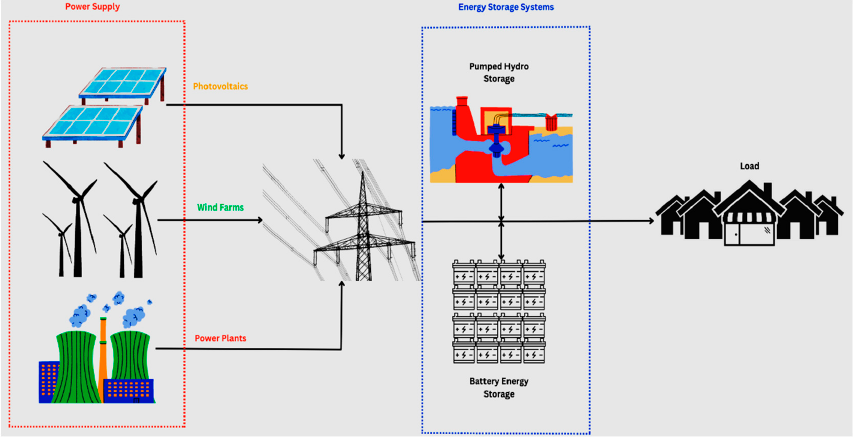
Figure 6. Schematic of hybrid wind/PV/thermal power plants integrated with different energy storage systems. Using a computational design strategy, Kim et al. [101] determined the dimensions of a hybrid power system that included national electric, solar, and fuel cells, and then determined the ratio values of the system. Between 0.46 to 0.54 was the ideal ratio of the amount of energy generated by fuel cells to that generated by solar cells. In addition, the authors provided a revised version of the uDEAS method, which stands for “univariate dynamic encoding algorithm for searches,” as a new optimization strategy. Bauer et al.